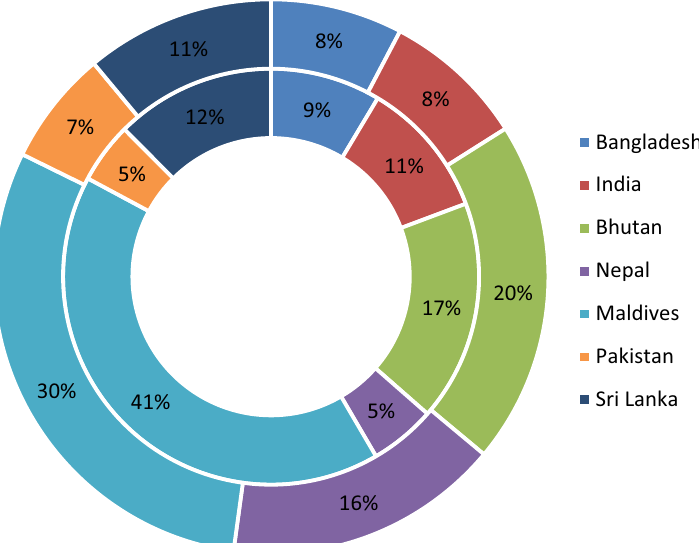
Fig. 1 The exports and imports of South Asian economies in 2017 (% of GDP). Source: World Bank (2020)